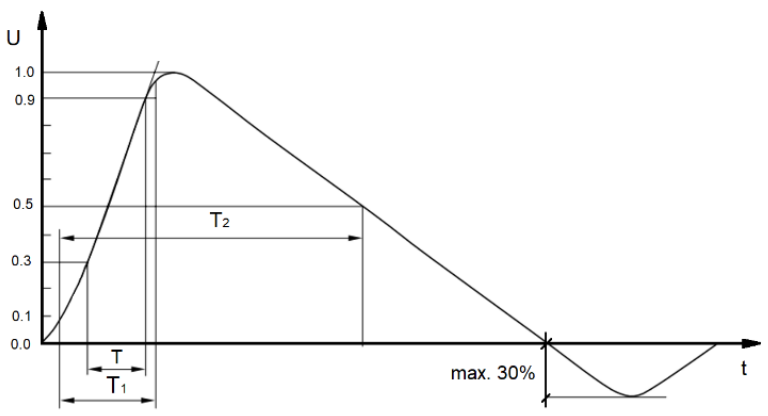
Figure 2. Surge waveform of open-circuit voltage based on [23].